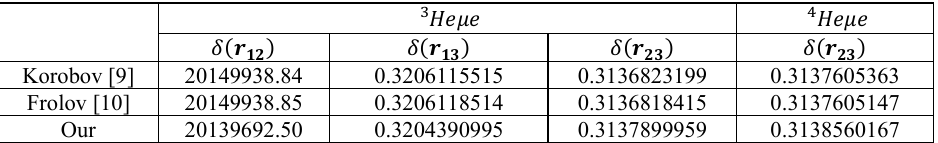
Table 1. Numerical values of the matrix elements of the function in electronic atomic units for the ground states in the muonic helium. 𝛿𝛿